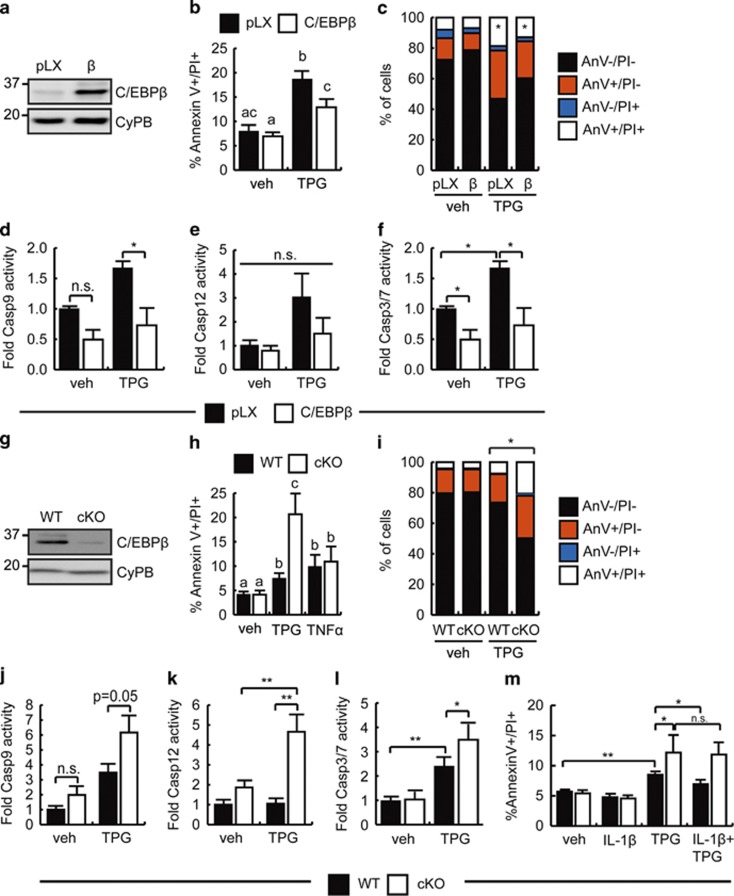
C/EBPβ promotes the survival of myoblasts. (a) C/EBPβ protein expression in proliferating C2C12 cells retrovirally transduced to express C/EBPβ or with empty virus (pLXSN). The migration of molecular weight markers, in kDa, is shown. Cyclophilin B (CyPB) is a loading control. (b) Percentage of dead cells determined by flow cytometry analysis of Annexin V and PI staining in vehicle and TPG-treated C2C12 stable cells. Means indicated with different letters are significantly different from one another, n=4. Gating strategy and sample plots are provided in Supplementary Figure S2. (c) Percentage of cells found in the Annexin V+/PI+, Annexin V+/PI–, Annexin V–/PI– and Annexin V+/PI+ populations from cells treated as in (b). Two populations indicated with an asterisk are significantly different from one another. Gating strategy and sample plots are provided in Supplementary Figure S2. (d) Caspase-9 activation in vehicle and TPG-treated C2C12 stable cell lines treated as in (b), shown relative to vehicle-treated empty virus control cells. NS, nonsignificant, *P<0.05, n=3. (e) Caspase-12 activation in vehicle and TPG-treated C2C12 stable cell lines treated as in (b), shown relative to vehicle-treated empty virus control cells. n=6. (f) Caspase-3/7 activity in TPG-treated C2C12-overexpressing C/EBPβ shown relative to C2C12 empty vector controls. *P<0.05, n=4. (g) Western analysis of C/EBPβ protein expression in primary myoblasts from WT and cKO mice treated with 4-OH tamoxifen for 48 h to induce excision. (h) Percentage of dead cells determined by flow cytometry in vehicle and TPG-treated WT and cKO myoblasts. Means indicated with different letters are significantly different from one another, n=6. Gating strategy and sample plots are provided in Supplementary Figure S3. (i) Percentage of cells found in the Annexin V+/PI+, Annexin V+/PI–, Annexin V–/PI– and Annexin V+/PI+ populations from cells treated as in (h). Matching populations in the cell lines indicated with an asterisk are significantly different from one another. Gating strategy and sample plots are provided in Supplementary Figure S3. (j) Caspase-9 activation in vehicle and TPG-treated primary myoblasts cell lines treated as in (h), shown relative to vehicle-treated WT cells. n=3. (k) Caspase-12 activation in vehicle and TPG-treated primary myoblasts treated as in (h), shown relative to vehicle-treated WT control cells. **P<0.01, n=3. (l) Caspase-3/7 activity in TPG-treated cKO myoblasts relative to WT. *P<0.05, **P<0.01, n=4. (m) Percentage of dead cells determined by flow cytometry in WT and cKO myoblasts pretreated with IL-1β and TPG for 24 hrs, as indicated. *P<0.05, **P<0.01, n=3. Gating strategy and sample plots are provided in Supplementary Figure S4